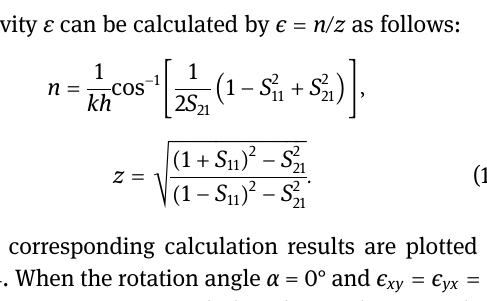
Figure 4. When the rotation angle α = 0 ° and ϵ xy = ϵ yx = 0, the effective permittivity only has diagonal terms, which